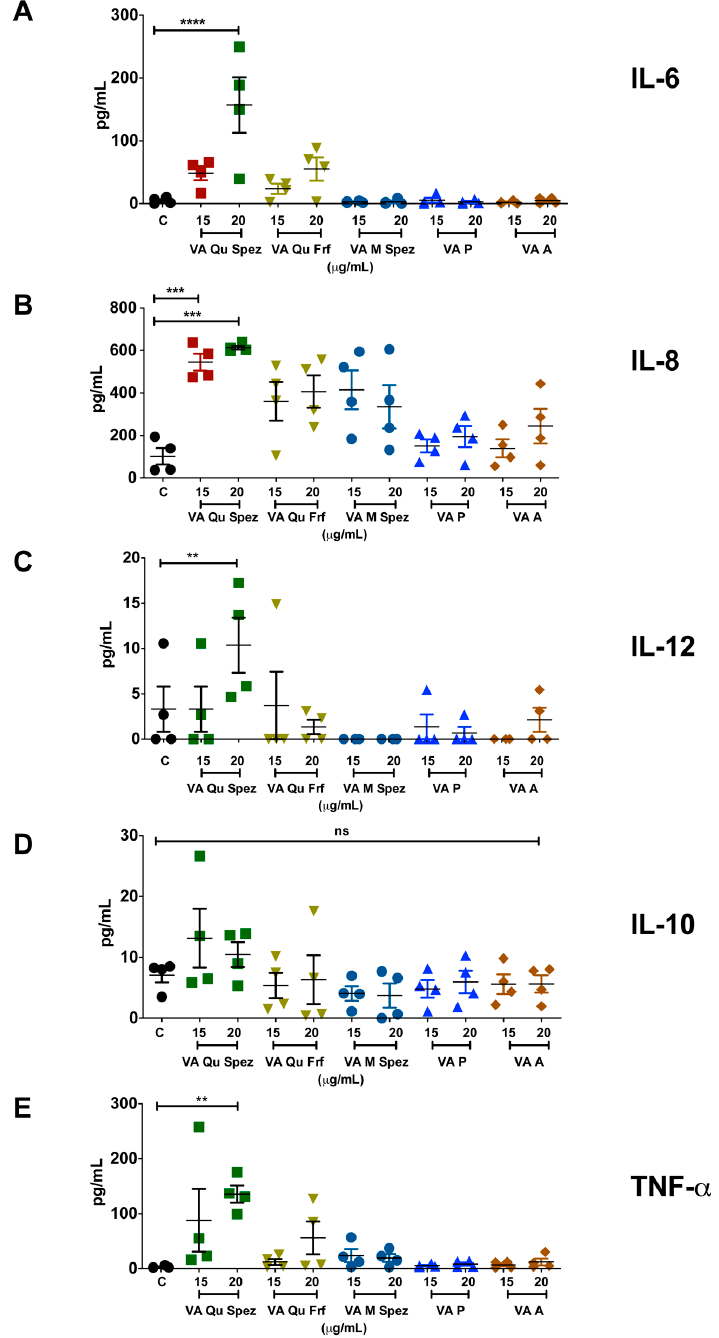
Figure 2. VA Qu Spez but not other VA preparations stimulate the secretion of DC cytokines. Immature DCs were untreated (control, labelled as ‘C’) or treated with five preparations of VA at various concentrations for 48 h. The amount (pg/mL, mean ± SEM, four independent donors) of ( A ) IL-6; ( B ) IL-8; ( C ) IL-12; ( D ) IL-10; and ( E ) TNF- α in cell-free supernatants was measured. ** p < 0.01, *** p < 0.001, **** p < 0.0001.